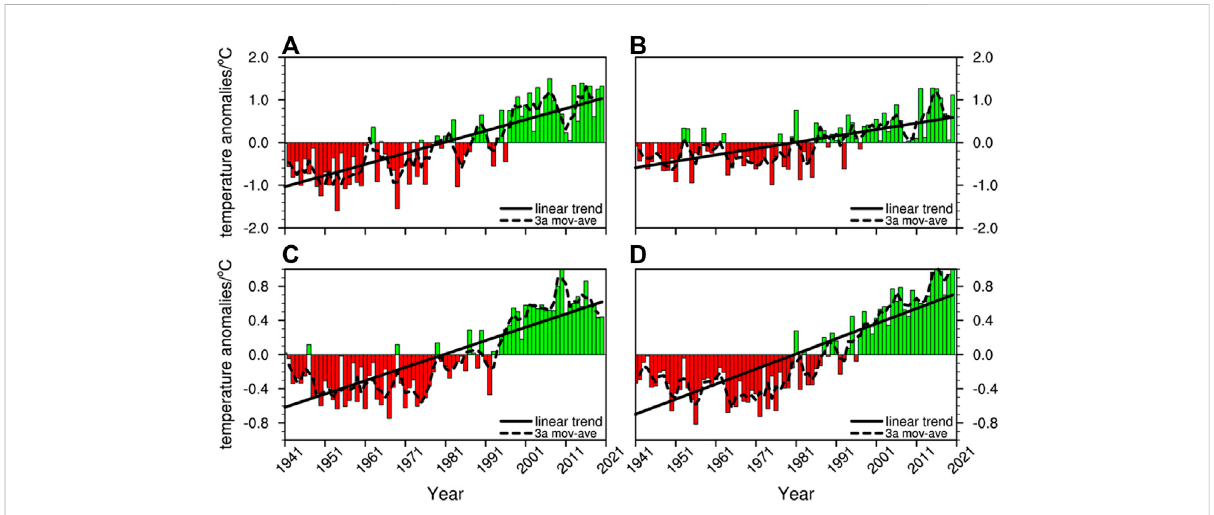
FIGURE 5 The 3-year moving averages of the tempreture anomalies in the (A) PCA, (B) NAm, (C) NAf and (D) the global from 1941 to 2020.